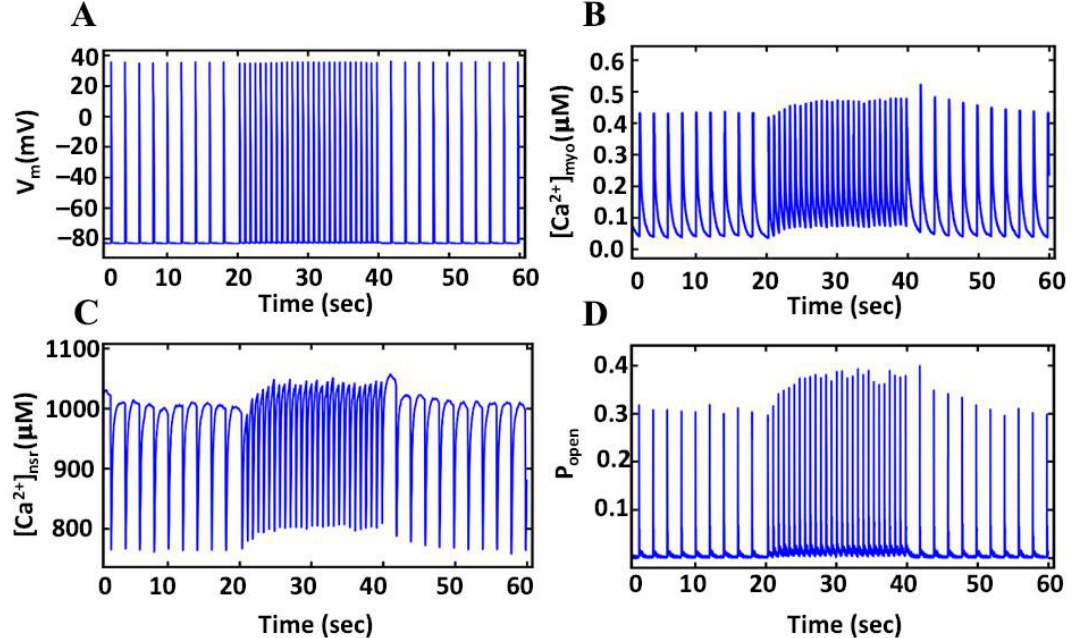
Figure 11. The force-frequency relationship in slow-rapid-slow pacing. ( A ) Membrane potential. ( B ) Myoplasmic Ca 2+ transients ([Ca 2+ ] myo ). ( C ) NSR Ca 2+ concentration. ( D ) The peak RyR2 open probability.